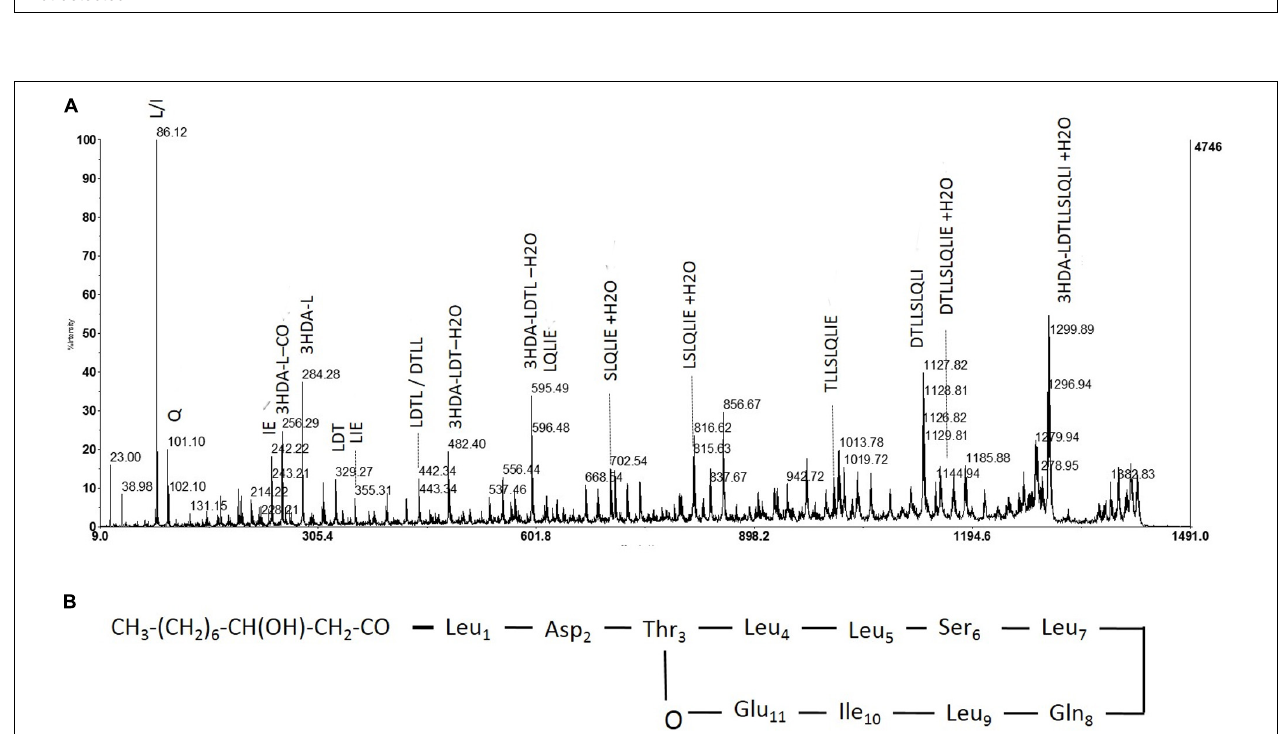
FIGURE 4 | Fragmentation pattern of lipopeptide m/z 1409 and proposed structure. (A) Product ions obtained by fragmentation using MALDI-TOF. (B) Determined structure of purified lipopeptide ( m/z 1409) based on mass spectrometric and NMR analysis.